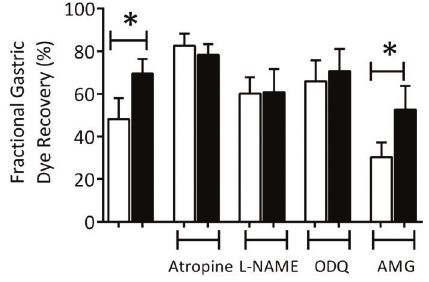
Figure 3. Neurohumoral mechanisms of acute exercise-induced gastric emptying delay. The fi gure shows the effects of pretreat- ment with atropine (1.0 mg/kg, ip ), L-NAME (10 mg/kg, ip ), ODQ (5.0 mg/kg, ip ), and aminoguanidine (AMG, 10 mg/kg, ip ) on gastric retention of a liquid test meal in rats that were subjected to the sedentary (white bars) or acute exercise (5%) (black bars) protocols. The data are reported as means ± SD. *P o 0.05 (ANOVA followed by the Tukey ’ s